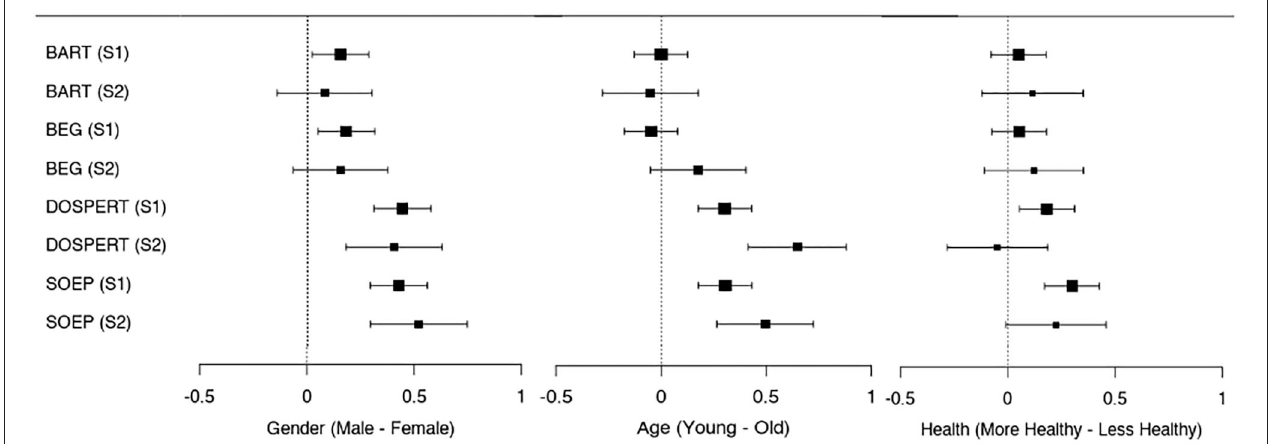
FIGURE 1 | Forest plot for the standardized (z-scored) mean differences with 95% confidence interval across the main risk measures in study 1 (general sample) and study 2 (UK representative sample) by gender, age (classified as young and old by median age), and self-reported health (classified as more and less healthy by